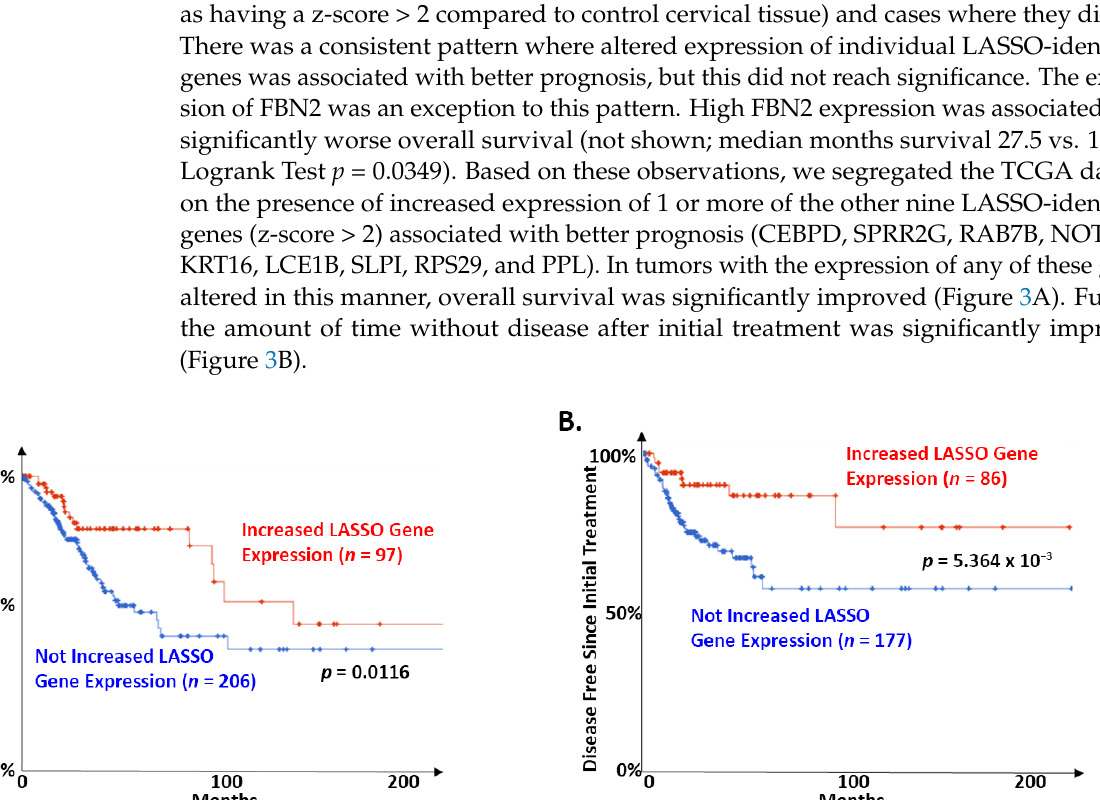
7 of 19 Figure 2. Heat maps showing the expression of NFX1-123-responsive genes at different stages of cervical cancer development. ( A ) A heat map organized by two unsupervised cluster analyses of the data. Dendrograms on the top and right show the results of these analyses. ( B ) A heat map